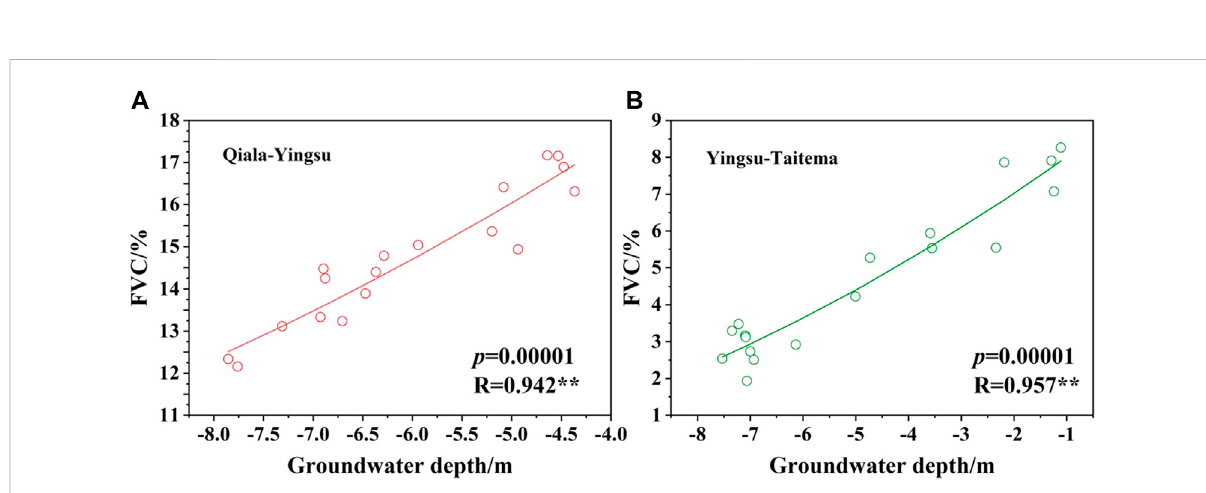
FIGURE 9 Correlation analysis of FVC and groundwater depth. (A) is Qiala-Yingsu, (B) is